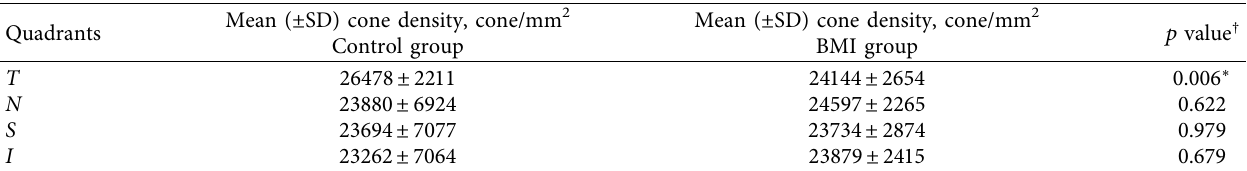
Table 4: Mean cone density in 4 retinal quadrants at 2 ° eccentricities in both groups ( n � 47) after Bonferroni correction (adjusted p value � 0.0125).